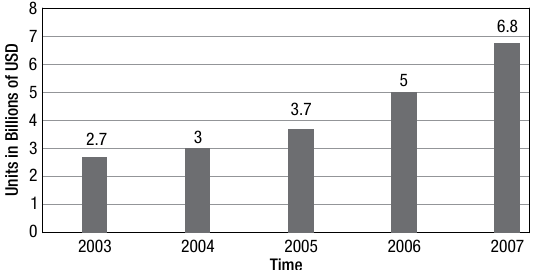
Fig. 1. Market scale of the biotech pharmaceutical industry in China